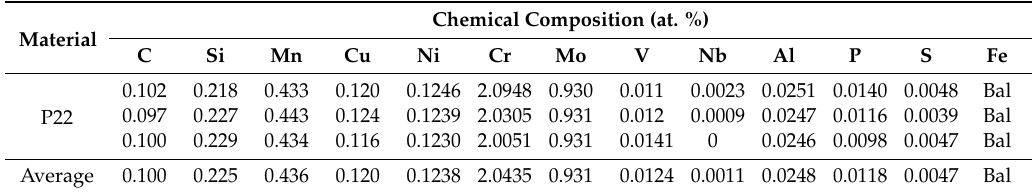
Table 1. Table 1. Chemical composition of 2.25Cr-1Mo steel (wt %).